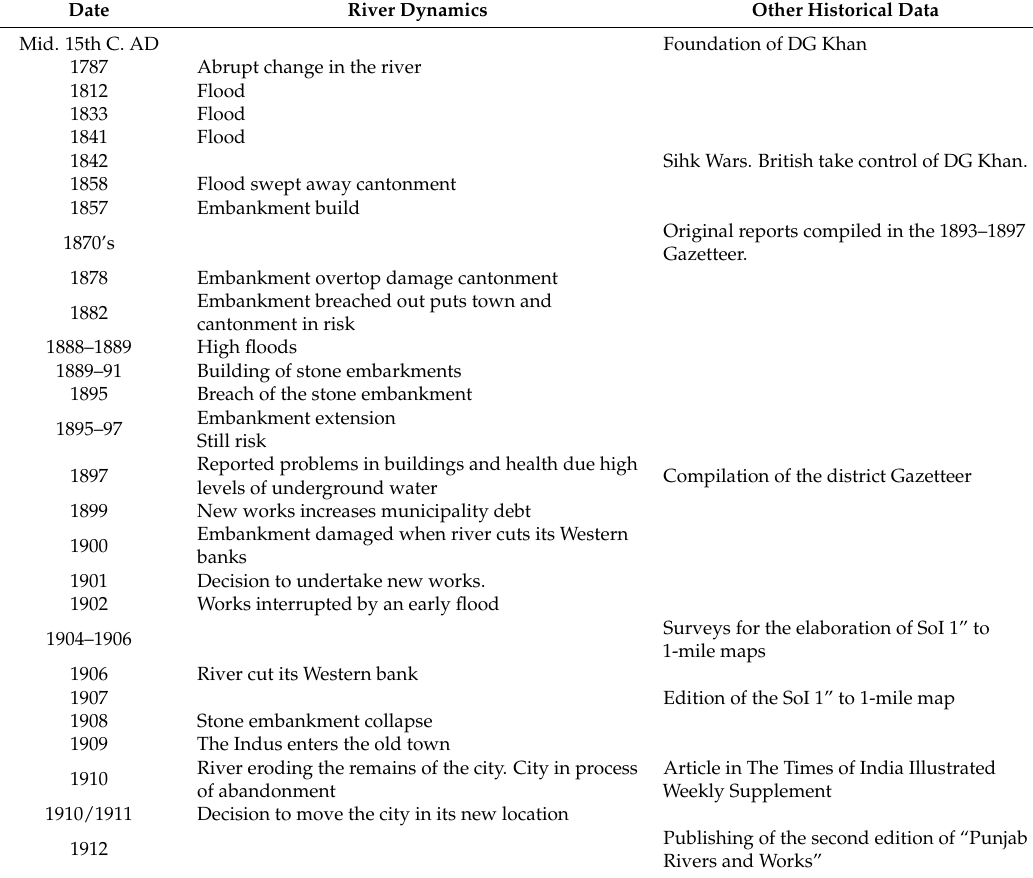
Table 1. Summary of references to the riverine dynamics during the nineteenth century recorded by the British colonial